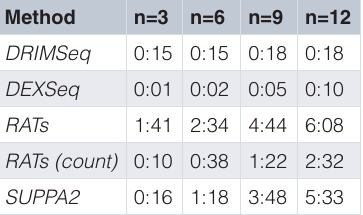
Table 1. Compute time of methods for differential transcript usage (DTU) in hours:minutes by per-group sample size, using one core. The fourth row, RATs (count), gives the compute time using the scaledTPM counts, and not the bootstrap